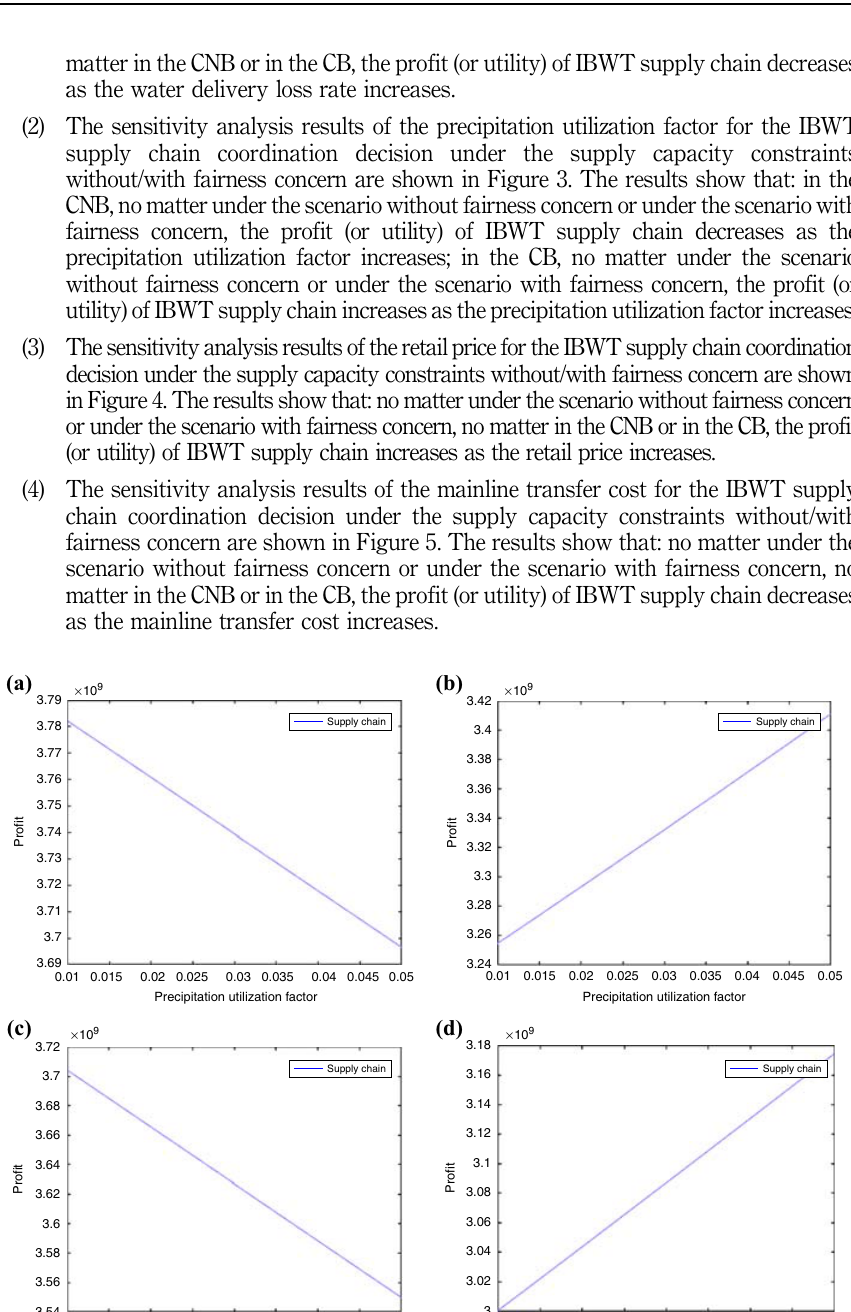
Figure 3. The impact of precipitation utilization factor change on the profit of IBWT supply chain without/with fairness concern